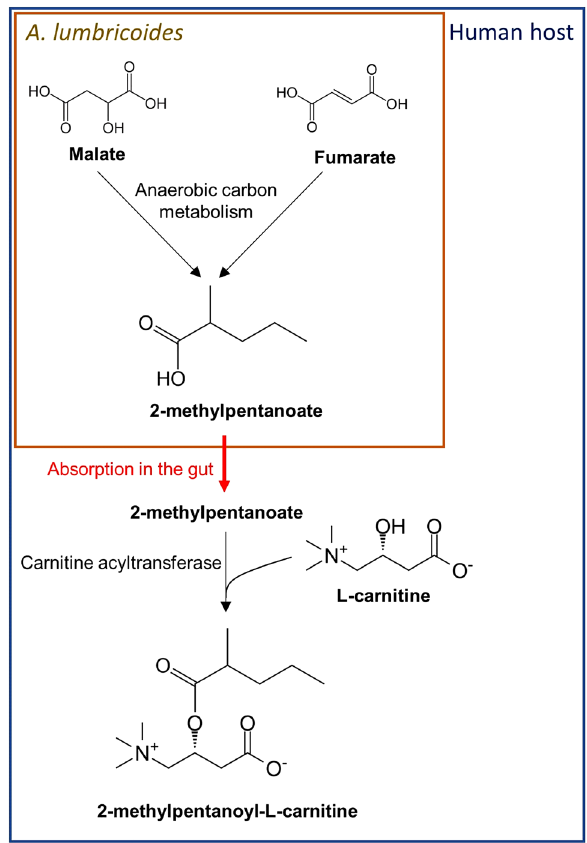
Figure 7. Presumable metabolic pathway of 2-MPC. The parasitic anaerobic carbon metabolism pathway leading to 2-methylpentanoate has been described in detail before 48